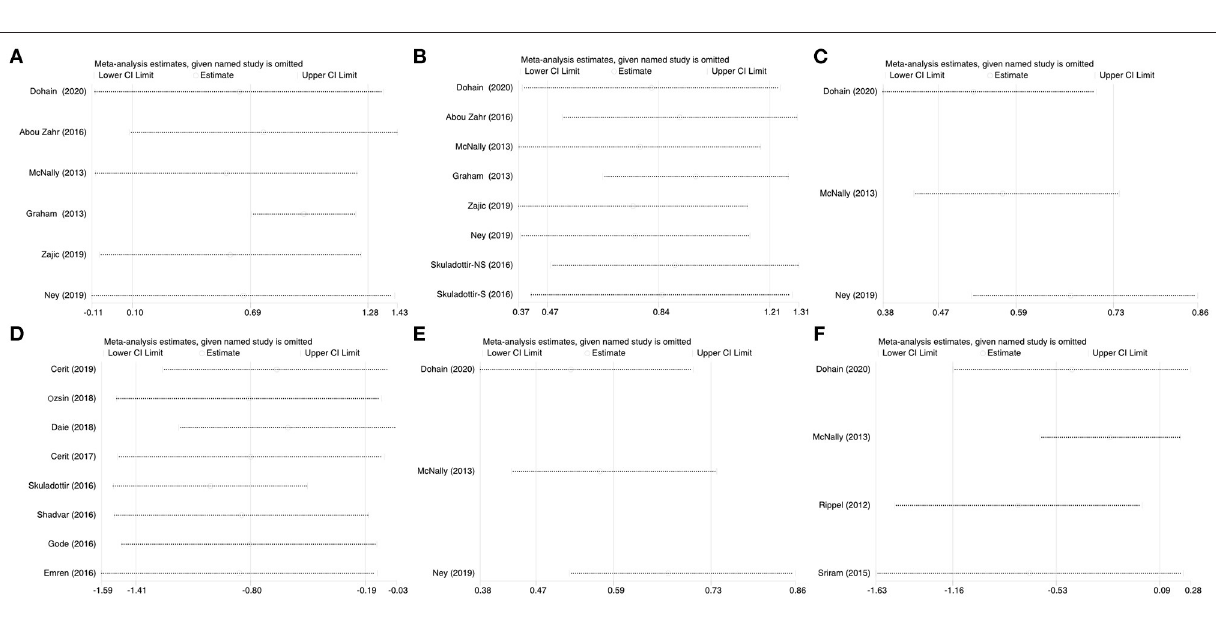
opposite and identified a significant difference in the duration of ICU stay [SMD, − 0.76; 95%CI ( − 1.52, − 0.012); P = 0.046] between